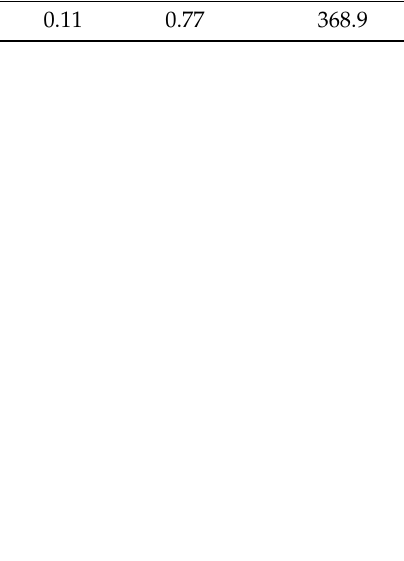
Table 1. Chemical composition (% by mass) and fineness of the cement.